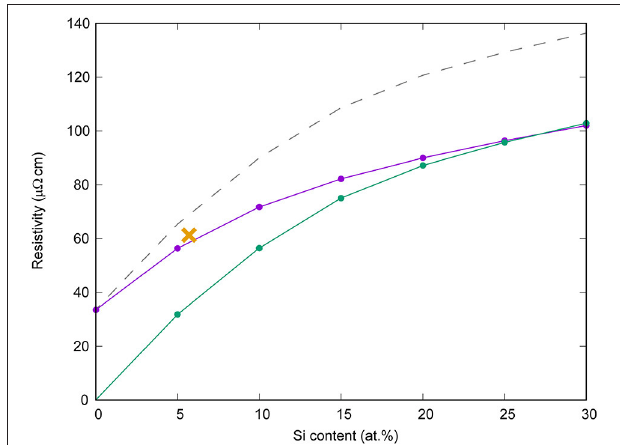
FIGURE 6 | Impurity resistivity of hcp Fe 100 − x Si x binary (green) and Fe 95 − x Si x S 5 ternary (purple) alloys as a function of silicon content at the volume of 19.10 Å ( ∼ 40 GPa) and zero Kelvin. Gray broken line shows the sum of the resistivity of Fe 95 S 5 and Fe 100 − x Si x (the Matthiessen’s rule). The orange cross represents the resistivity of hcp Fe 89.3 Si 5.7 S 5.0 alloy measured at ∼ 40 GPa and ambient temperature (Suehiro et al.,